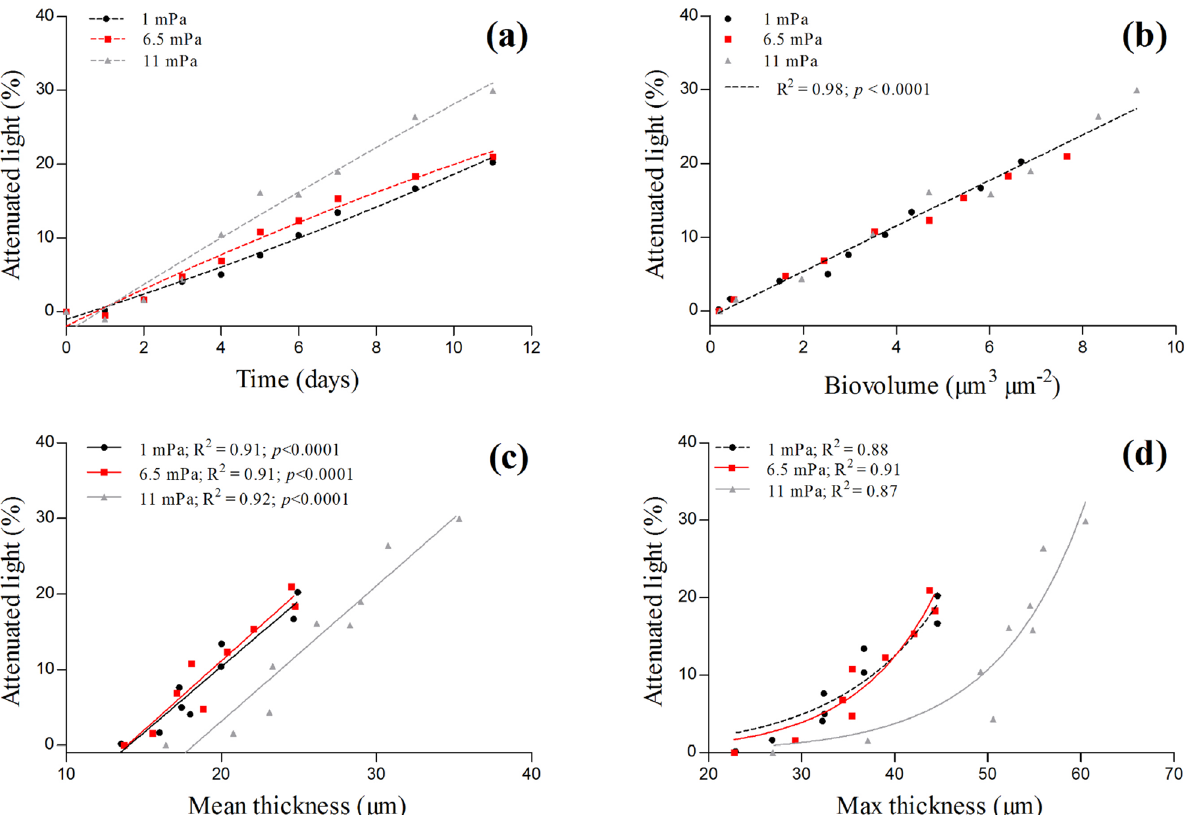
Figure 3. Attenuated light in the biofilms of C. vulgaris grown at three different hydrodynamic shears (1.0, 6.5 and 11.0 mPa). In ( a ) the attenuated light is shown as a function of time. The relationships among the light attenuated in the biofilms and the structural parameters biovolume ( b ), mean thickness ( c ) and maximal thickness ( d ) of the biofilms are also reported. The data represent the mean of at least three independent biological replicates (n ≥